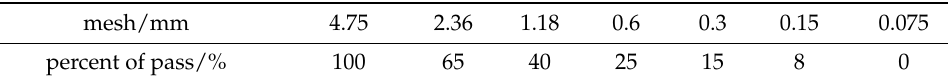
Figure 1. Plot of five times filling proportion and clearance rate. Table 3. Passing rate of fine aggregate.